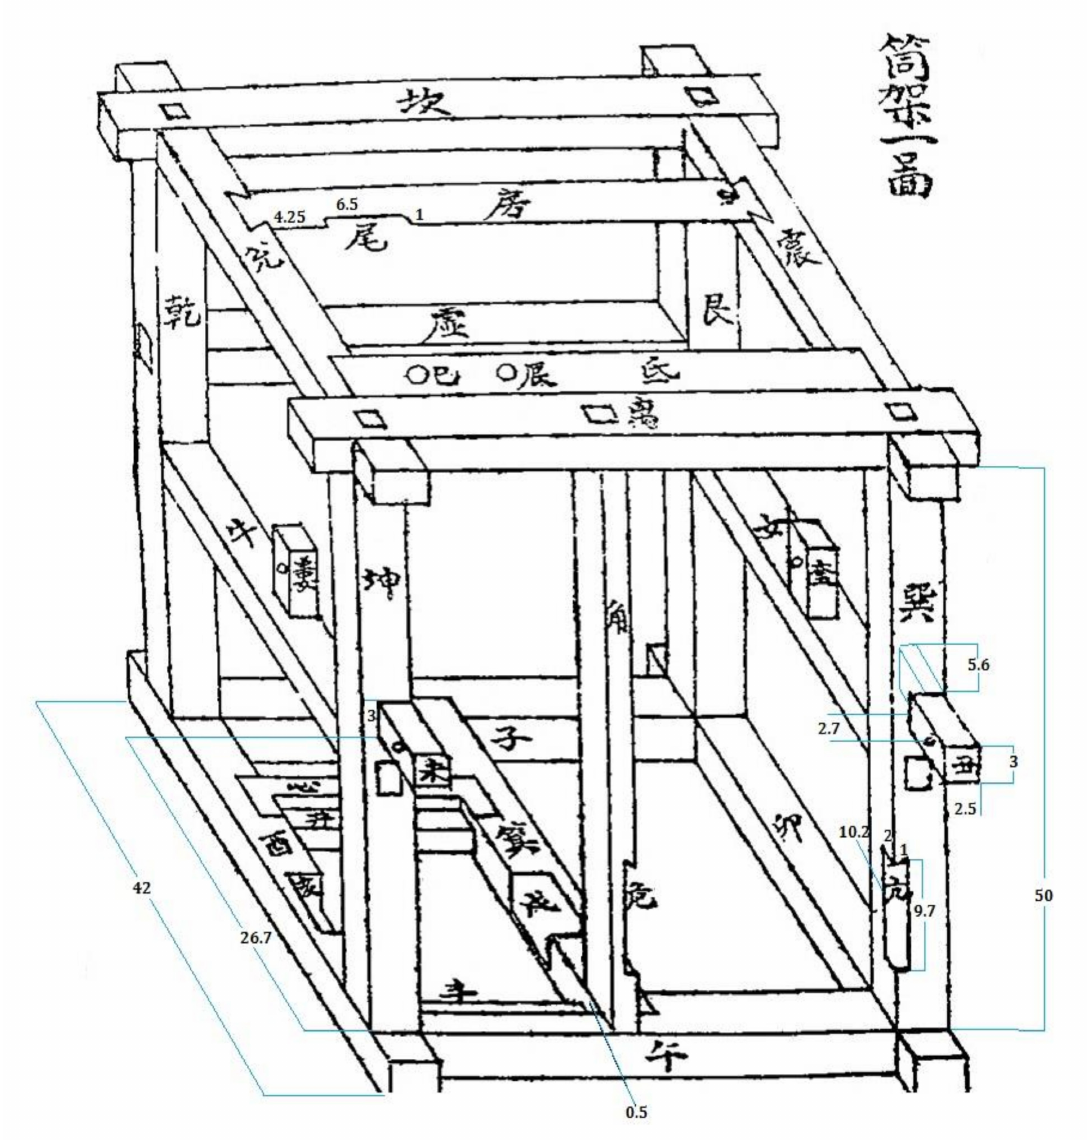
Figure 1. Jseungcha Dohae